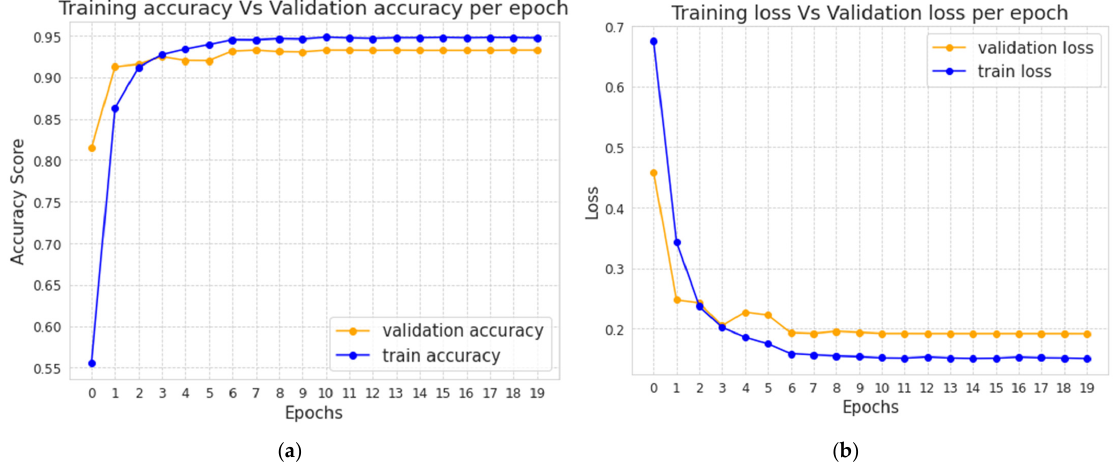
Figure 9. BiLSTM models training vs. validation performance comparison. ( a ) Training and valida- tion accuracy per epoch; ( b ) Training and validation loss per